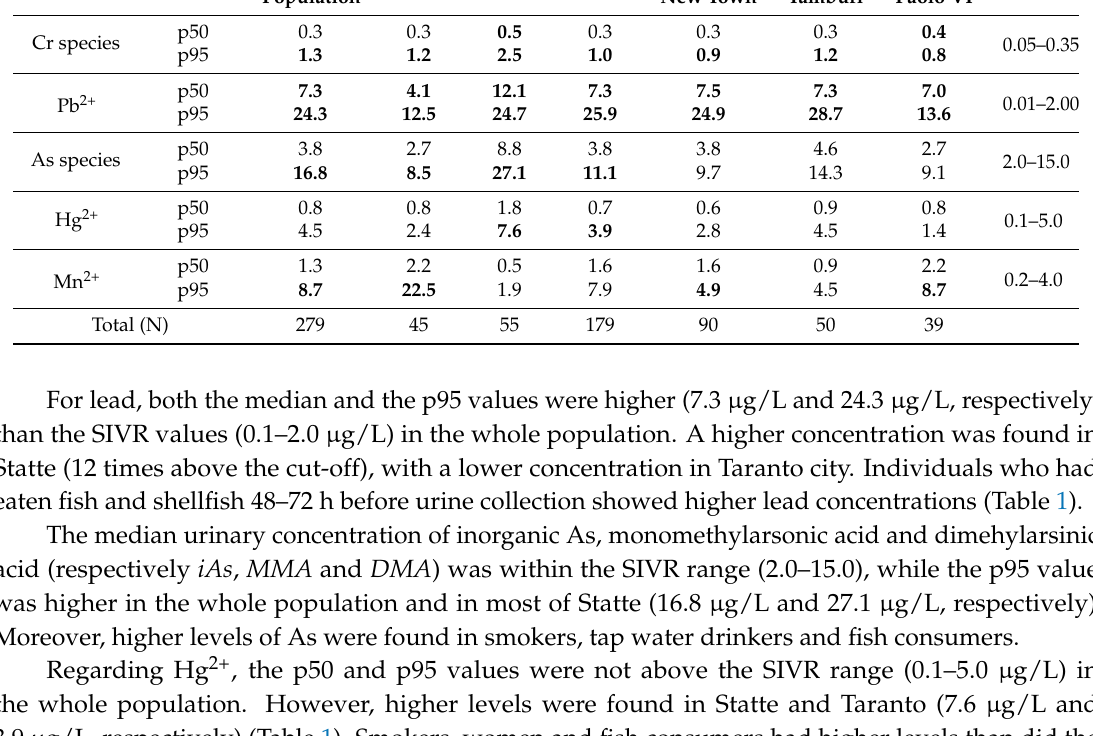
Table 1. Urinary concentrations (in µ g/L) attesting environmental exposure in the Apulia Region. Bold values are higher than the Societ à Italiana Valori di Riferimento (SIVR) range. Whole Laterza Compound Measure Population